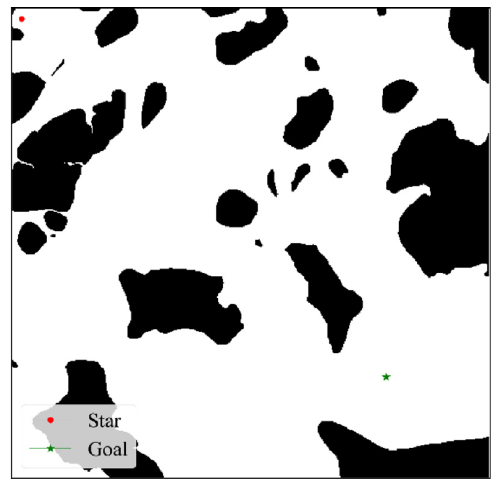
Figure 8 Experimental environment of path planning